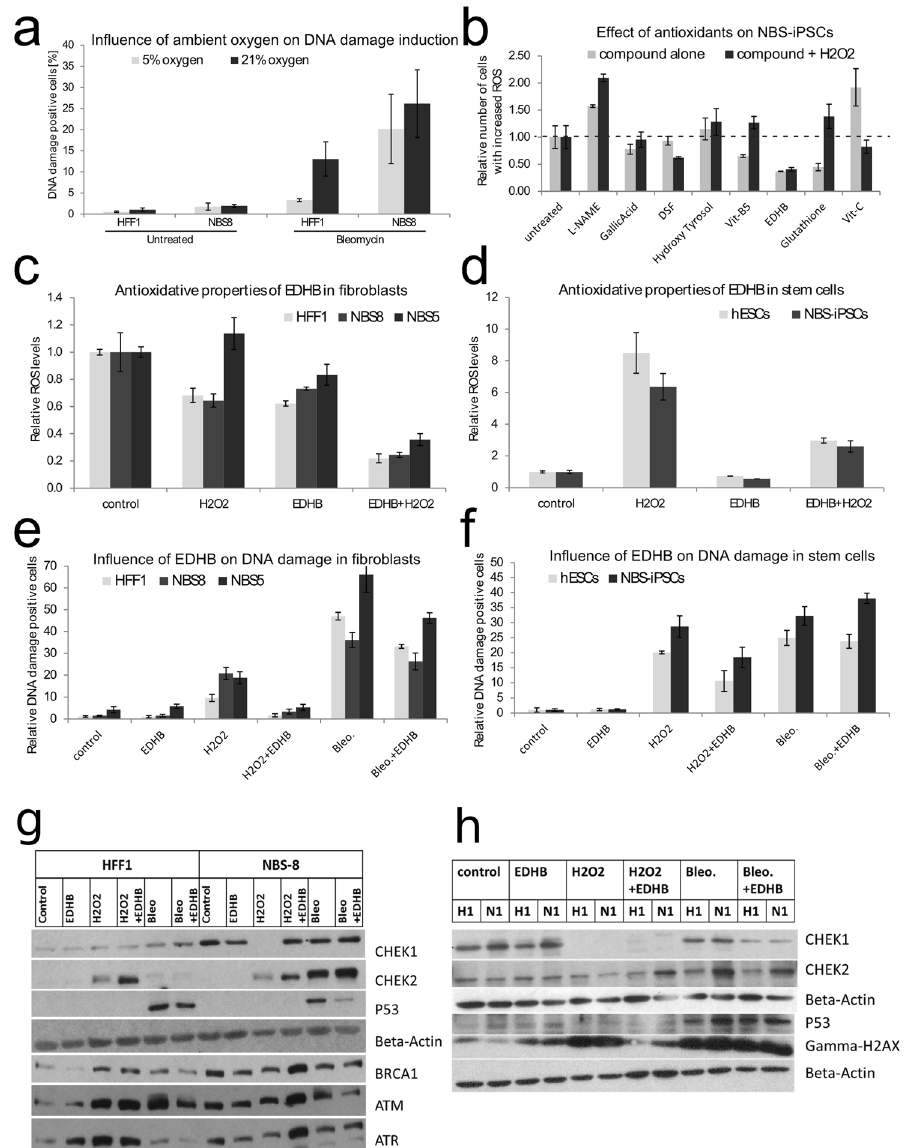
Figure 4. Response of NBS cells to oxidative stress and antioxidants. ( a ) The abundance of DNA damage measured by FACS-based detection of the DNA double-strand marker gamma-H2AX in HFF1 and NBS8 fibroblasts. DNA damage was induced by 30 µ g/ml Bleomycin and compared under ambient (21%) and physiological (5%) oxygen concentrations. ( b ) NBS8-iPSCs were treated with either H 2 O 2 , several compounds known to influence DNA repair and ROS levels, or both. Internal ROS levels were then measured by FACS- based detection of the fluorescent ROS marker DCF-DA. The results were normalized to the untreated or peroxide-alone treated conditions respectively. ( c ) The influence of EDHB on internal ROS levels was tested on control (HFF1) and patient fibroblasts (NBS5, NBS8). The cells were either treated with EDHB alone or in combination with H 2 O 2 to stimulate oxidative stress conditions. ( d ) Same experiment as in ( c ), but comparing control (hESCs) and patient (NBS-iPSCs) pluripotent stem cells. ( e ) The influence of EDHB on DNA damage (by detection of gamma-H2AX) was tested on control (HFF1) and patient fibroblasts (NBS5, NBS8). The cells were either treated with EDHB alone, in combination with H 2 O 2 to stimulate oxidative stress conditions, or in combination with Bleomycin to stimulate mutagenic stress conditions. ( f ) Same experiment as in ( e ) but comparing control (hESCs) and patient (NBS-iPSCs) pluripotent stem cells. Bars indicate SD between independent experiments ( n = 3). ( g , h ) Influence of DNA damage and EDHB on phosphorylation of DNA damage signaling proteins. Cells were treated with EDHB (antioxidant and inducer of HIFpathway), hydrogen peroxide (H 2 O 2 ) and radiomimetic bleomycin (Bleo). ( g ) Immunofluorescent detection of phosphorylated signaling proteins in fibroblasts (HFF1, NBS-8) after SDS-PAGE. ( h ) Immunofluorescent detection of phosphorylated signaling proteins in hESCs (H1) and NBS-8-iPSCs (N1) after SDS-PAGE. Each lane of b-Actin corresponds to the lanes directly above and b-Actin is always unphosphorylated. For the sake of better readability western blots were